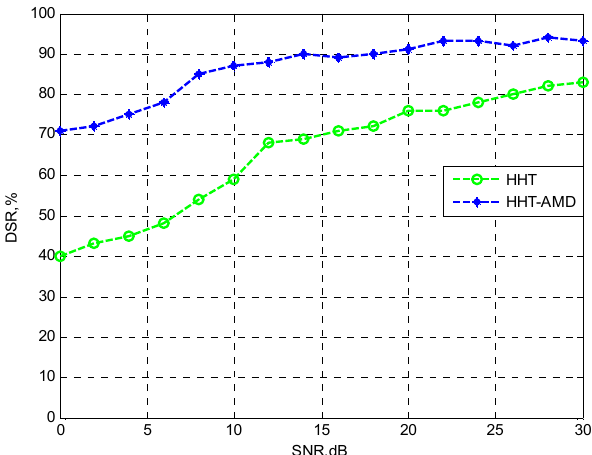
Figure 9. The comparison of DSRs against SNR (signal-to-noise ratio) between HHT-AMD and HHT.